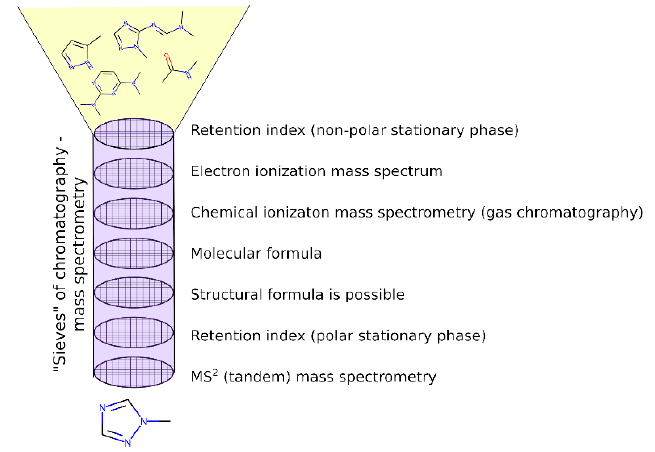
Figure 2. Overview of the workflow for non-target analysis, and the criteria used. Molecular formula and tandem mass spectrometry data were acquired with high performance liquid chromatography– high-resolution mass spectrometry with electrospray ionization.